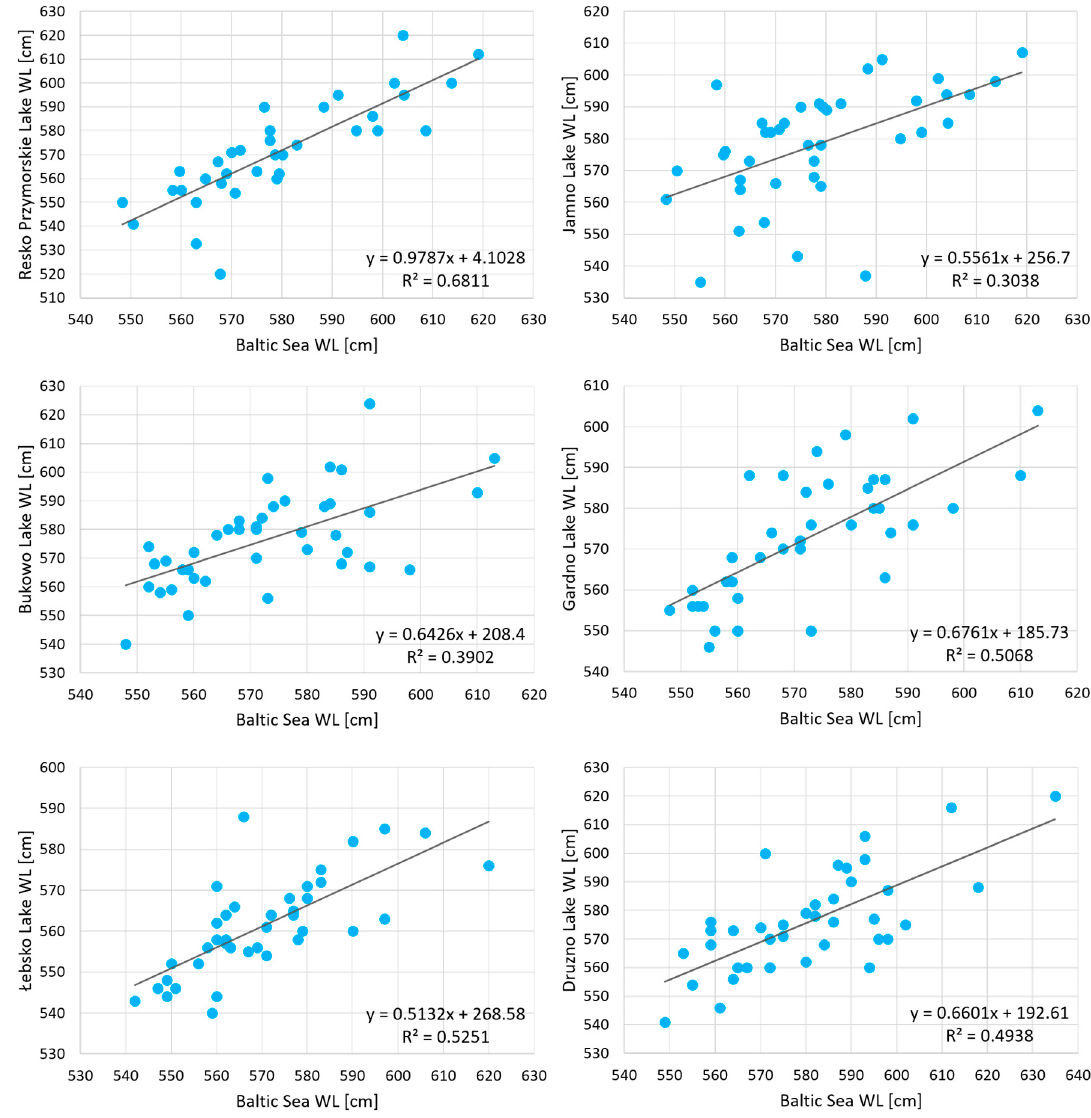
Figure 3. Correlations of maximum annual water levels of the analyzed lakes with maximum annual water levels in the Baltic Sea.